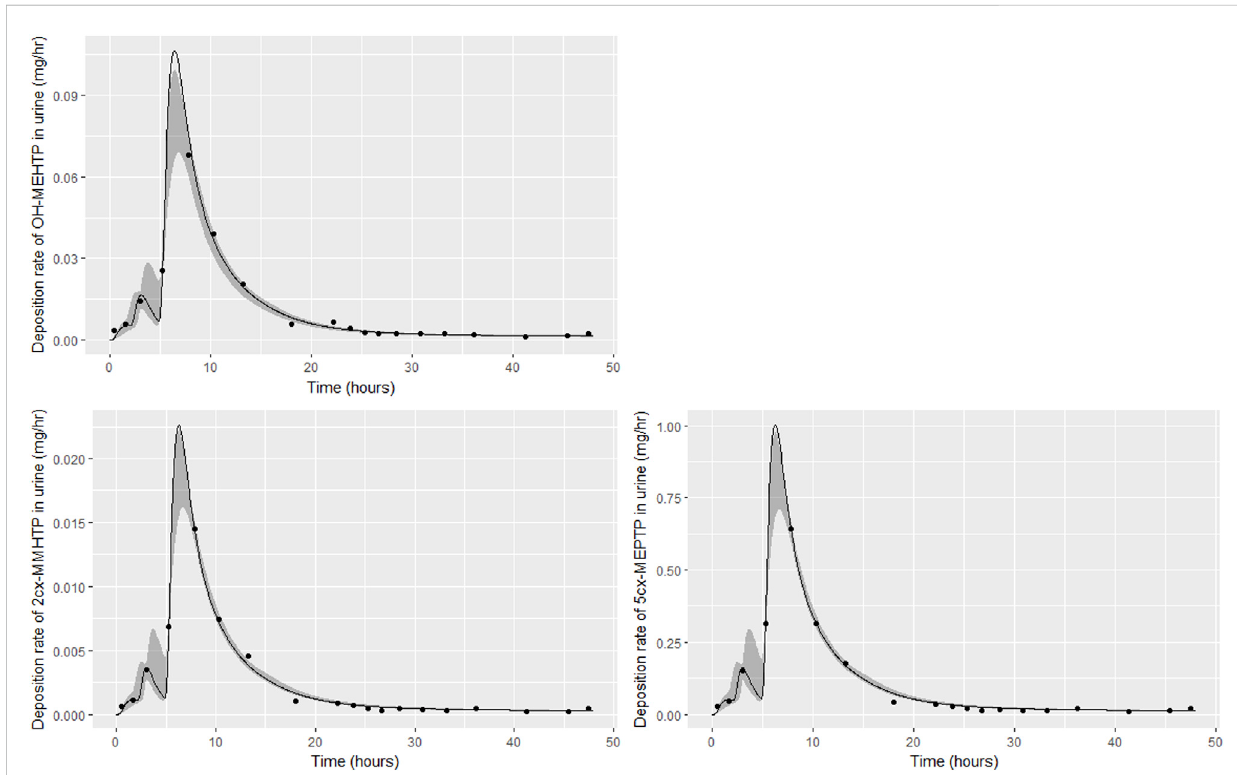
FIGURE 5 Fitofthecalibratedmodeltourinaryexcretiondatafromindividual (B) .Panel (A) OH-MEHTP(mg/h); (B) 2cx-MMHTP(mg/h); (C) 5cx-MEPTP(mg/h). The central estimates indicated in plots correspond to the posterior mode whereas the shaded regions represent 95% intervals for the respective